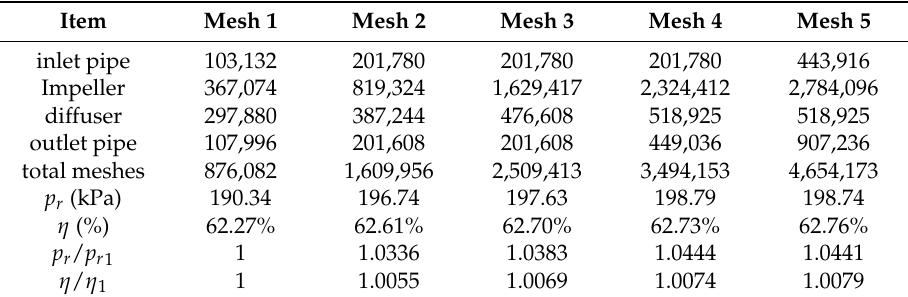
Table 2. Multiphase pump pressure rise p r and efficiency η versus mesh elements.